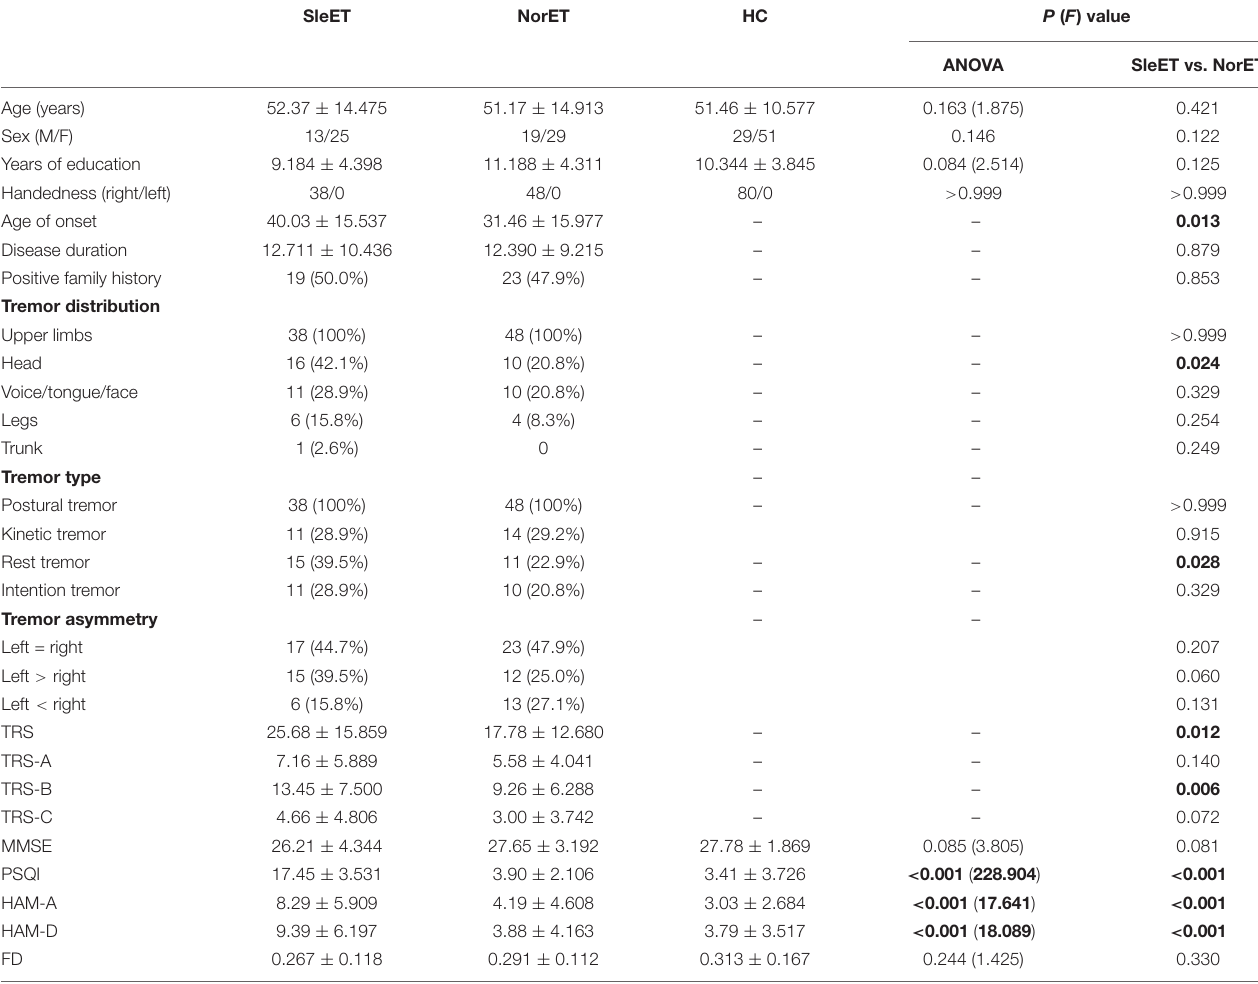
TABLE 1 | Demographics and clinical characteristics of the SleET and NorET patients and HCs.